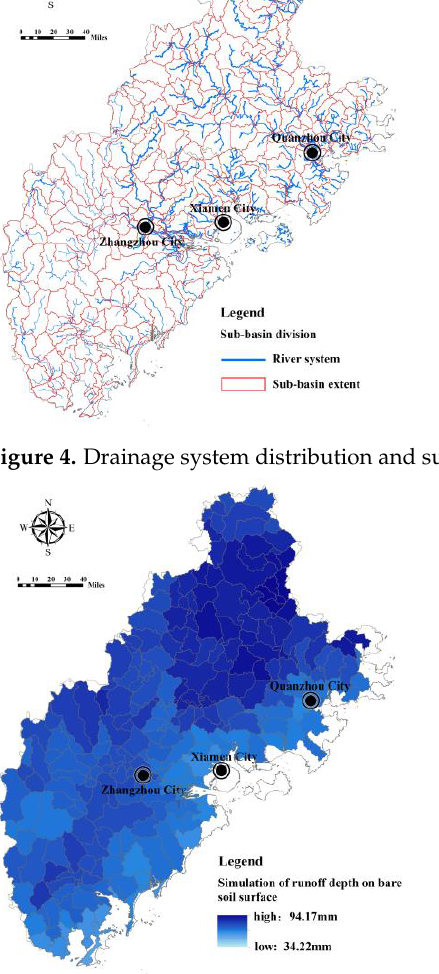
Figure 5. Runoff simulation of bare land surface in Fujian Delta.